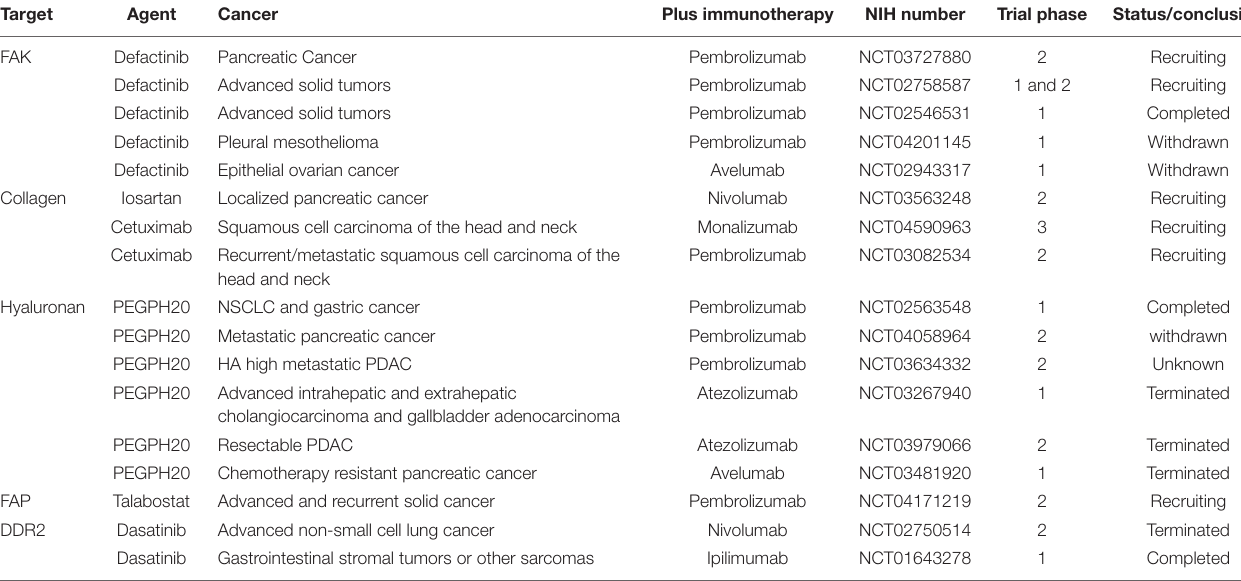
TABLE 1 | Examples of clinical trials combining agents targeting the tumor ECM with